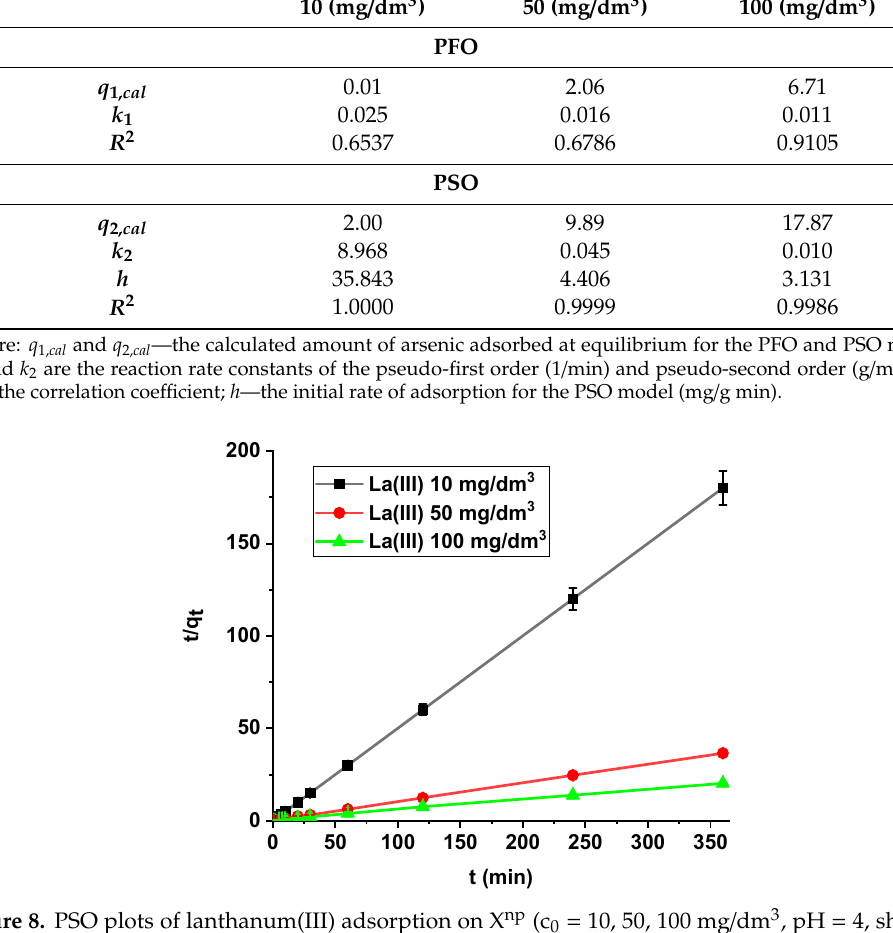
Table 3. Kinetic parameters of lanthanum(III) adsorption on X np . Kinetic Parameters